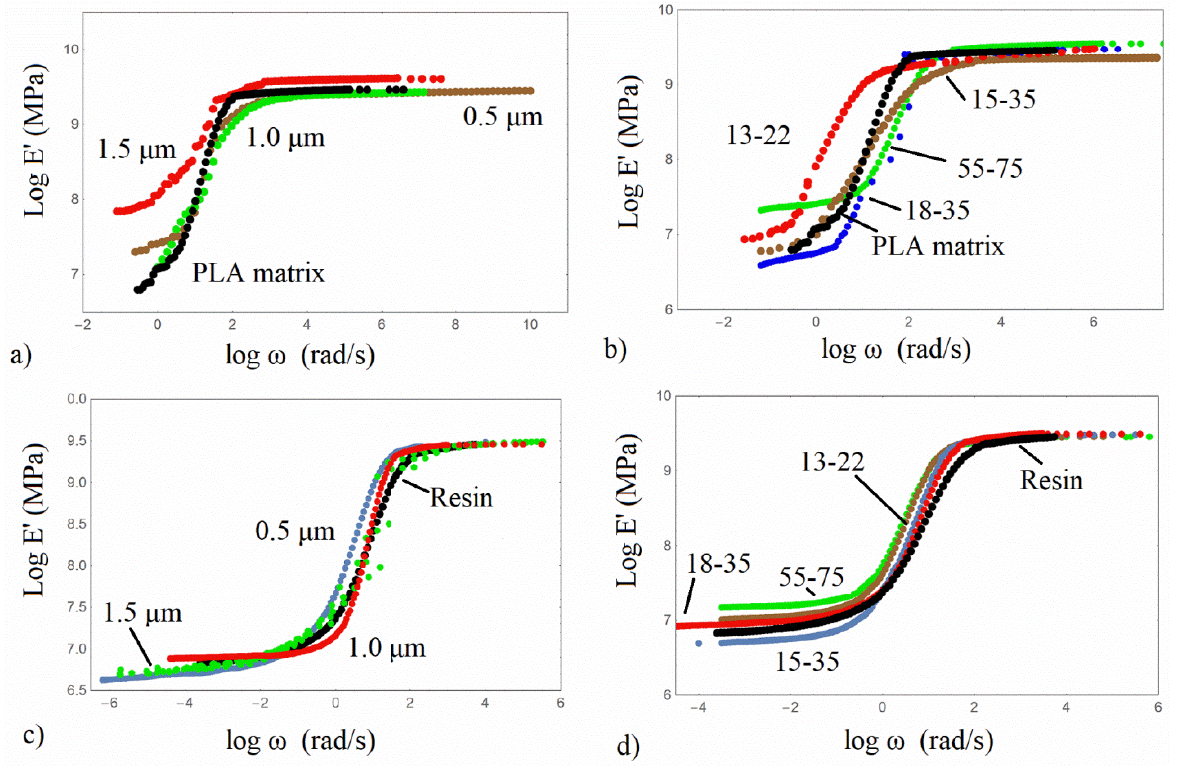
Figure 7. Master curves of storage modulus of the composites examined. ( a , b ) PLA/based silica composites, ( c , d ) Resin/based silica composites.